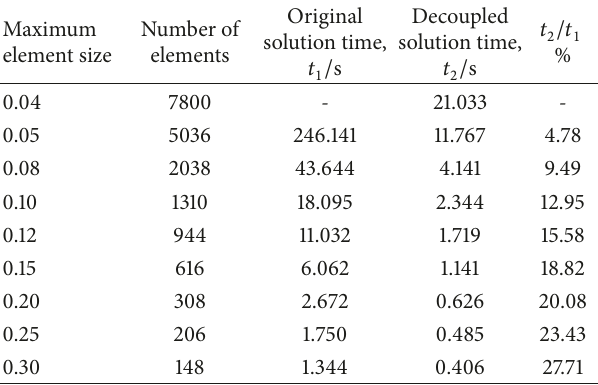
Table 5: Comparison of solution time in 2D model using direct solver,